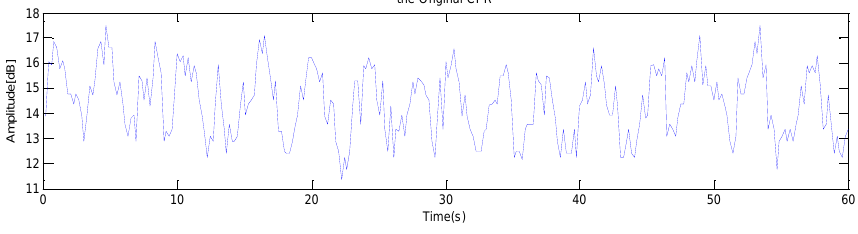
Figure 12. Raw WCI for normal breathing using C-Band.